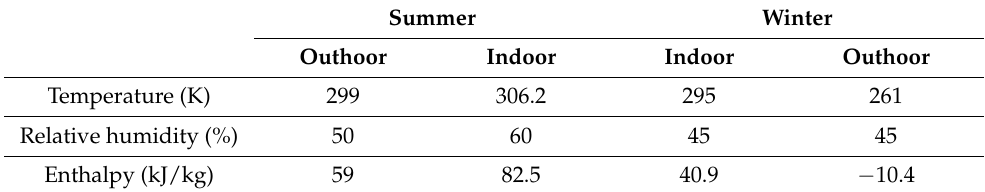
Table 7. Indoor and outdoor meteorological parameters in summer and winter in Beijing